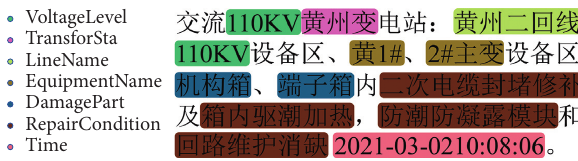
Figure 9: Entity recognition results.